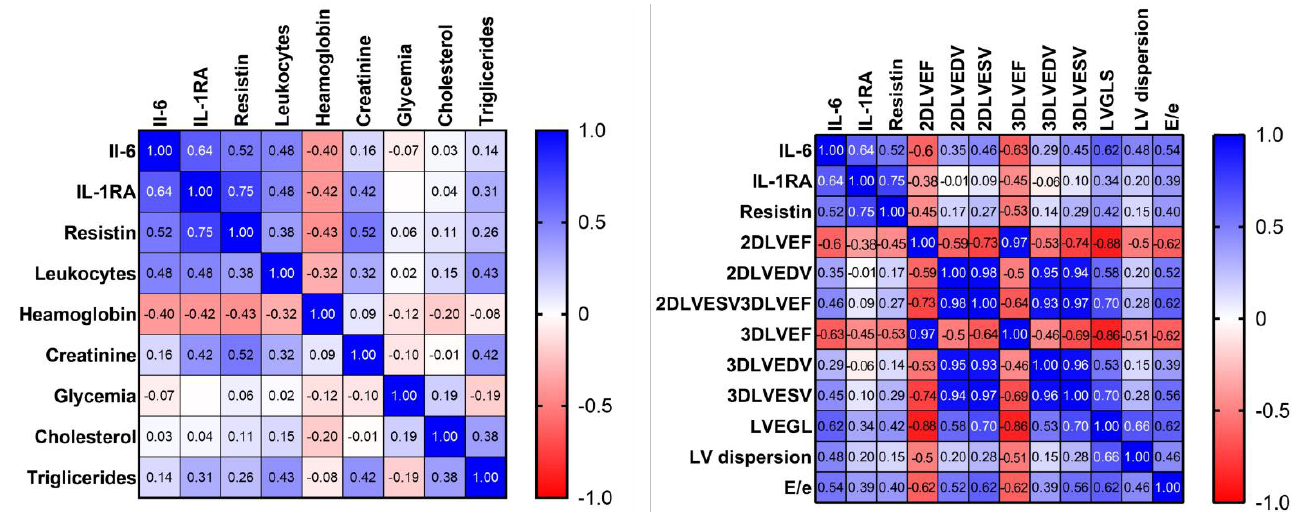
7 of 19 Table 3. Univariate binary logistic regression to assess the ability of various parameters to predict LVR.